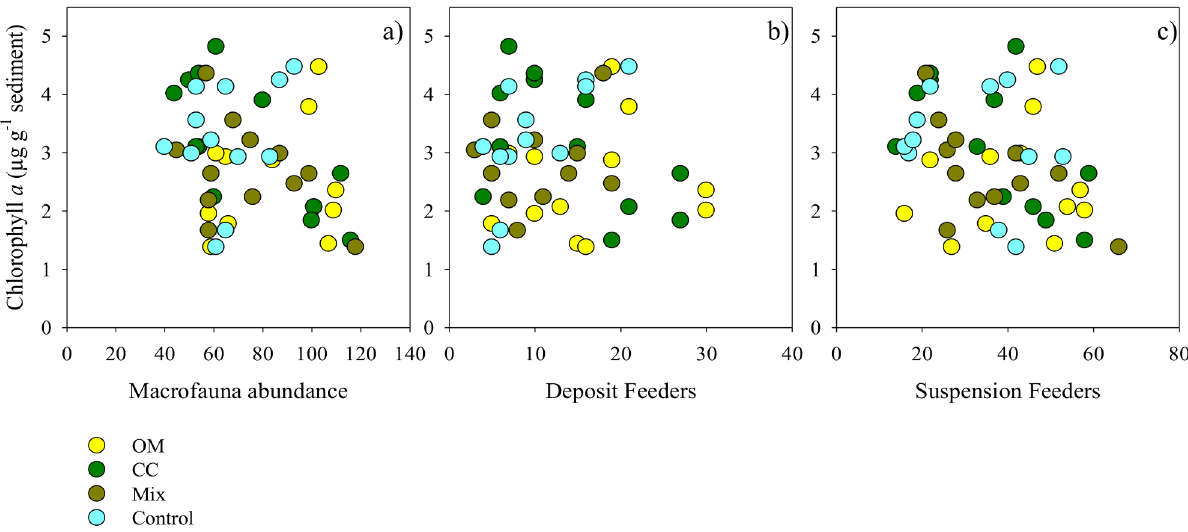
Figure 3. Biplots showing the relationship between chlorophyll a vs. macrofauna abundance, and the main feeding guilds. The panels show the general relationship across the sampling area. Chlorophyll a ( m g g 2 1 sediment), total macrofauna abundance (number of individuals), main feeding guilds (abundance of deposit and suspension feeders; DF and SF, respectively). Plots are raw data. (Treatments: Organic Matter, Calcium carbonate, Mix,